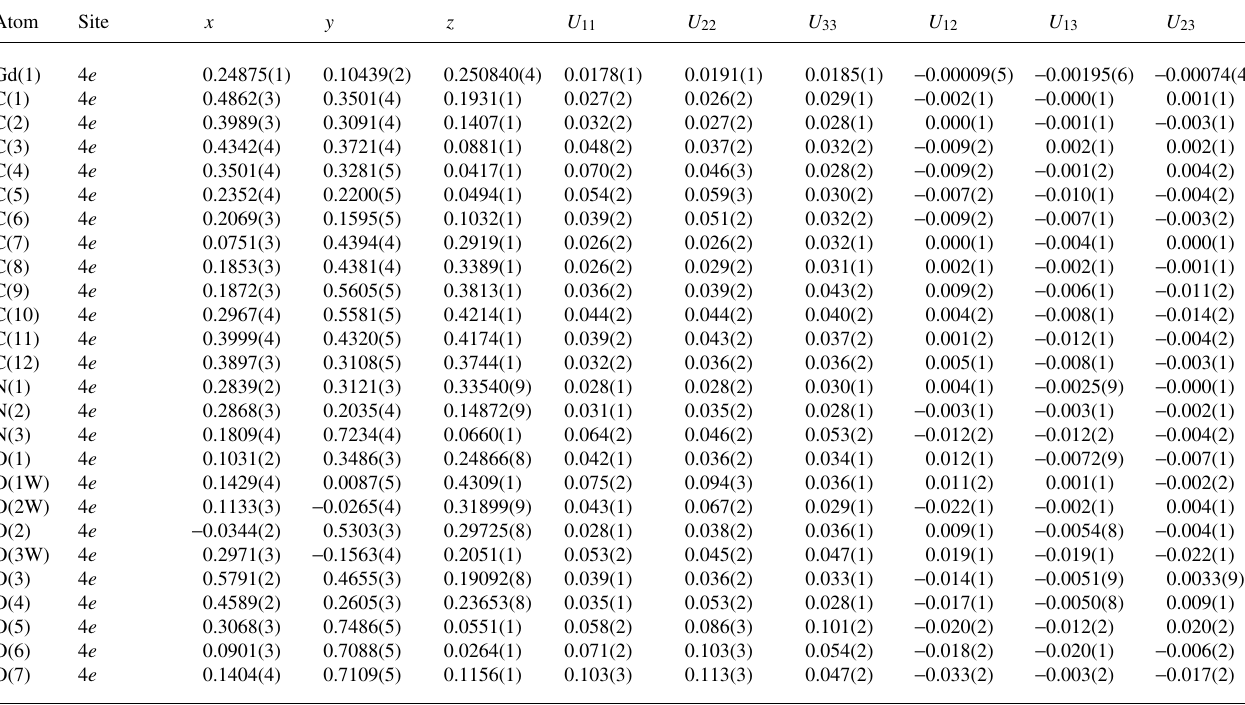
Table 3. Atomic coordinates and displacement parameters (in Å 2 )